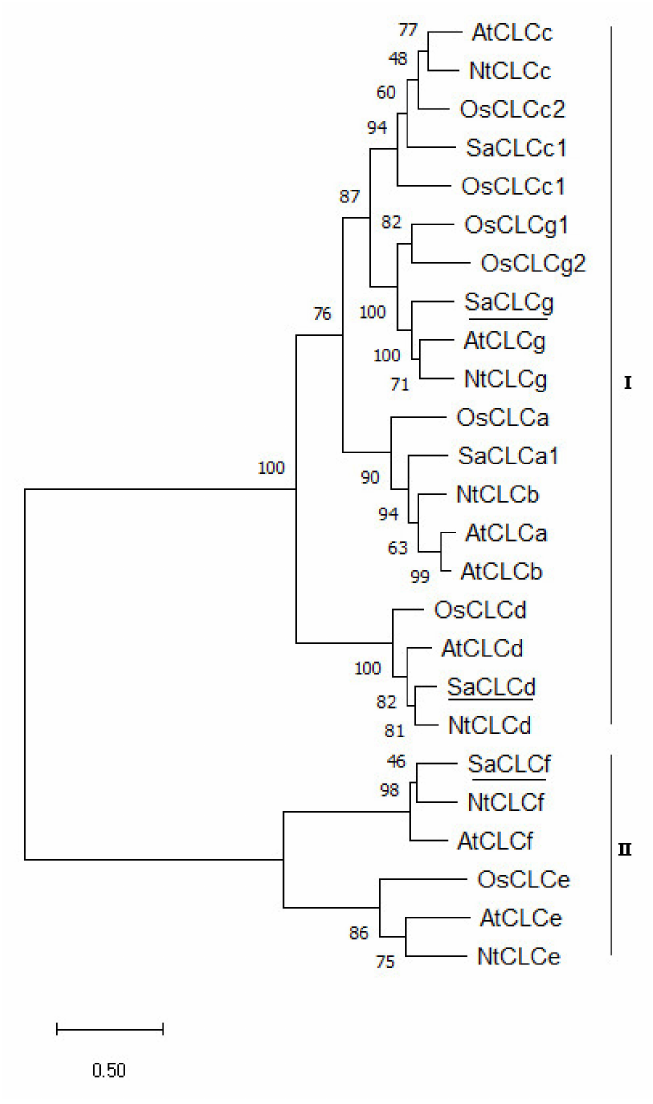
Figure 2. Phylogenetic tree of CLC family proteins of A. thaliana , O. sativa , N. tabacum, and S. altissima . AtCLCa (NP_198905.1), AtCLCb (NP_189353.1), AtCLCc (NP_199800.1), At- CLCd (NP_197996.1), AtCLCe (NP_567985.1), AtCLCf (NP_564698.1), AtCLCg (NP_198313.2), OsCLC1 (XP_015633162.1), OsCLC2 (XP_015622009.1), OsCLC3 (XP_015626588.1), OsCLC4 (AAO19370.1), OsCLC5 (XP_015636607.1), OsCLC6 (XP_015650515.1), OsCLC7 (XP_015620662.1), NtCLCc (NP_001312418.1), NtCLCb (NP_001312163.1), NtCLCd (XP_016512457.1), NtCLCe (XP_016461326.1), NtCLCf (XP_009787963.1), NtCLCg (XP_016468444.1), SaCLCa1 (ANG09048.1), SaCLCc1 (AVQ93350.1), SaCLCd (OK626332), SaCLCf (OK626333), and SaCLCg (OK626334). All protein sequences were taken from the protein database (NCBI). Subgroup I is the “eukaryotic” branch, and subgroup II is the “prokaryotic” branch. The phylogenetic tree was built in the MEGA 11 using the maximum likelihood method based on the Jones–Taylor–Thornton model. The number of bootstrap replicates was 1000; the values of bootstrap support are indicated near the nodes. Scale: 0.5 substitutions per